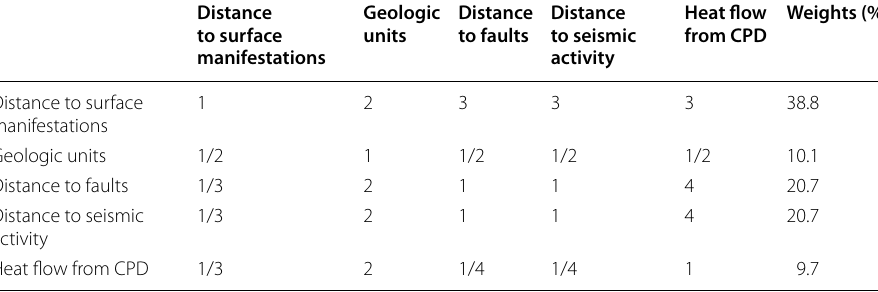
Table 3 Judgment matrix and weights of